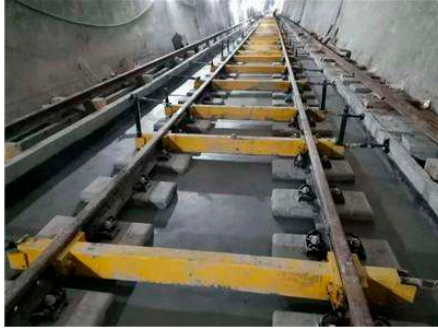
Figure 6. LVT construction site in the tunnel.